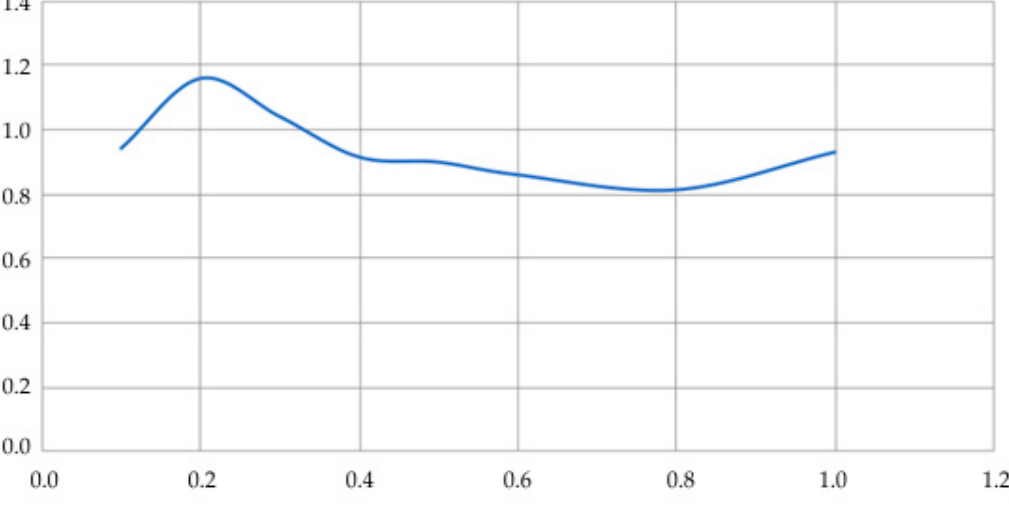
ρ on thickness h 4 of the surface layer E 4 at 1600 4